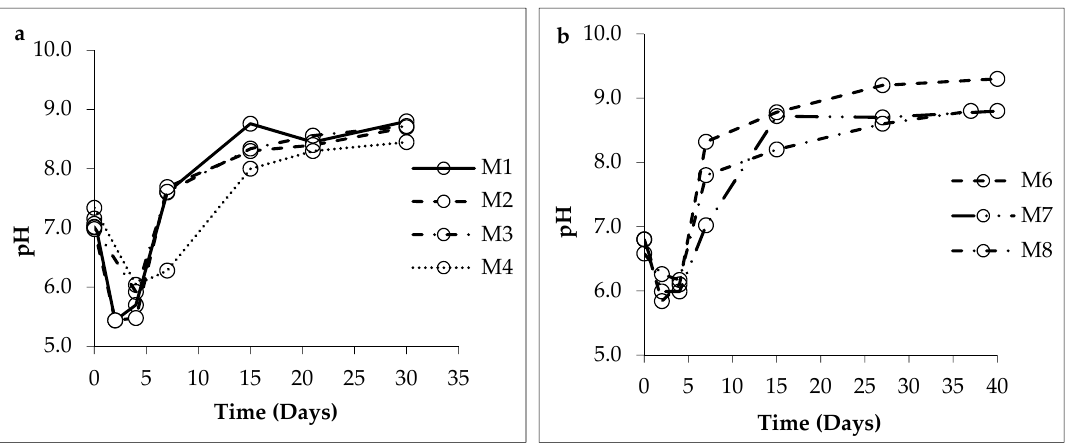
Figure 2. Evolution of pH during the precipitation experiments: ( a ) M1-M4; and ( b ) M6-M8 experiments.